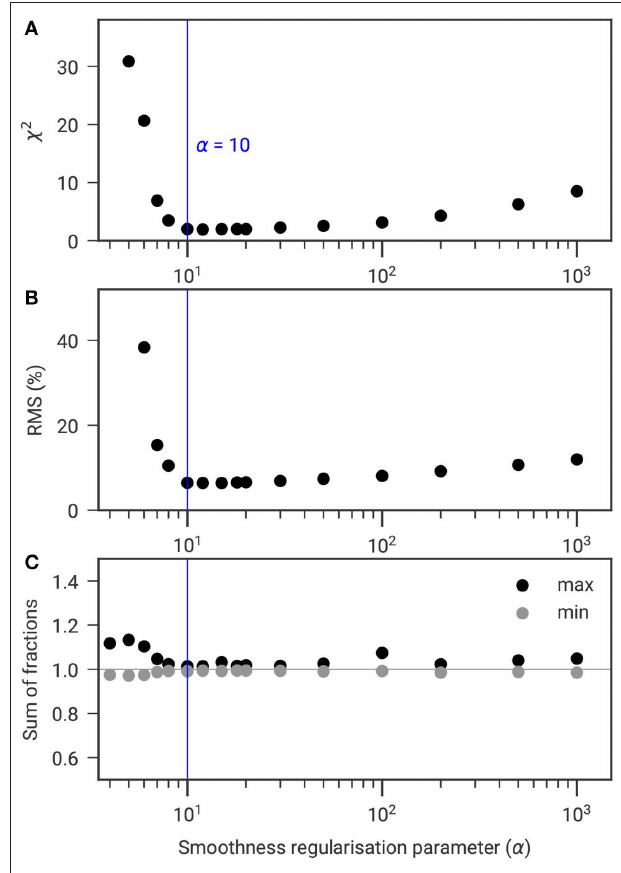
FIGURE 5 | Scatter plot of the smoothness regularization parameter α against (A) χ 2 , (B) RMS, and (C) minimum and maximum sum of the four fractions to determine the most adequate value of α for the Cervinia field site (for constant β and